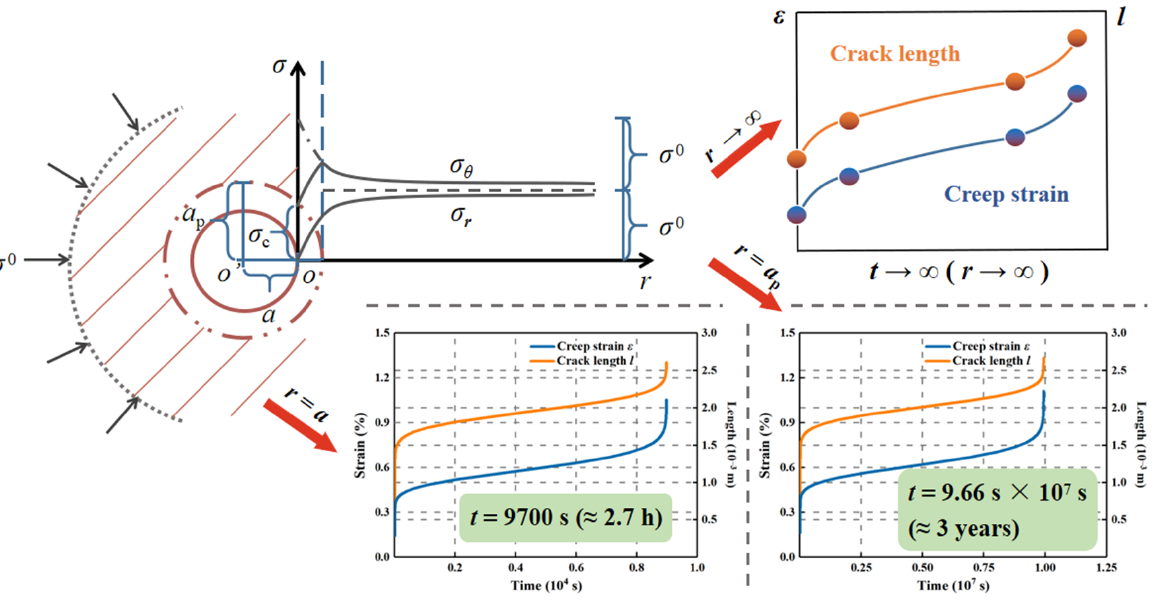
Figure 8. Time-dependent evolution of crack length and strain with distance from the center of tunnel section in the elastoplastic analytical model.